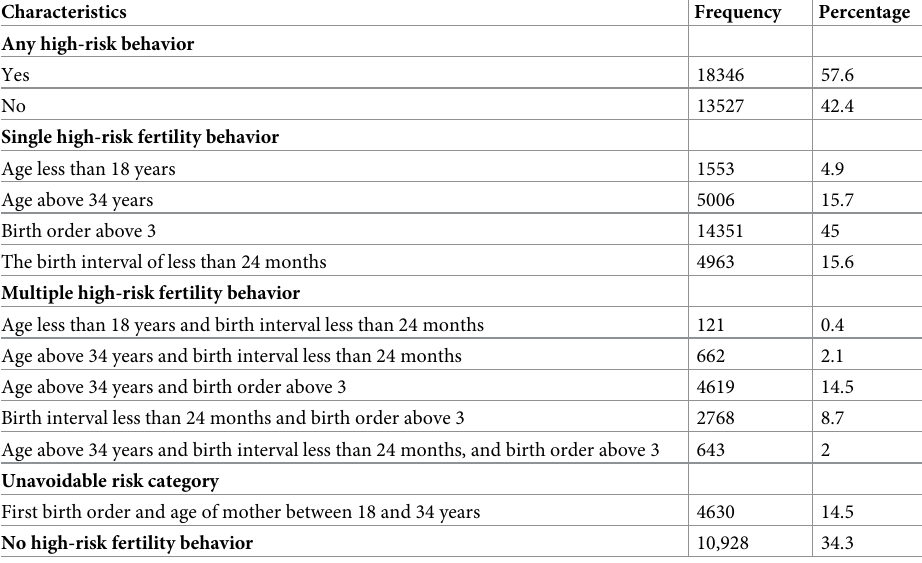
Table 3. High-risk fertility behavior of reproductive age women in east Africa